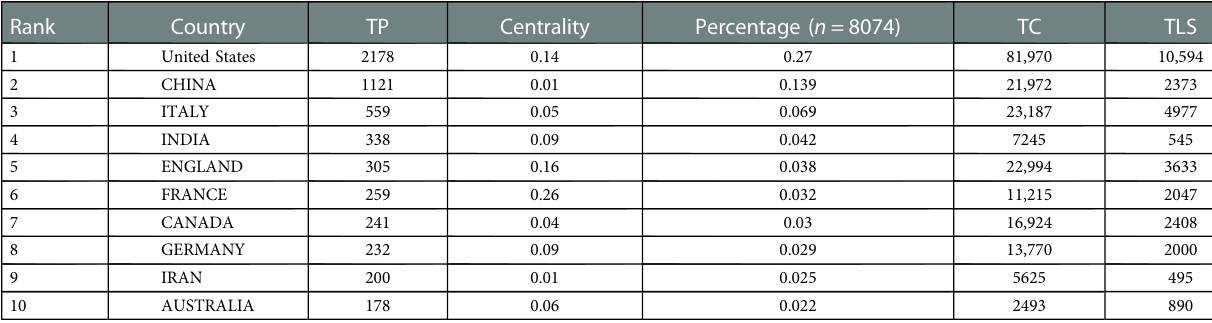
TABLE 1 The top 10 countries/regions involved in cardiotoxicity.